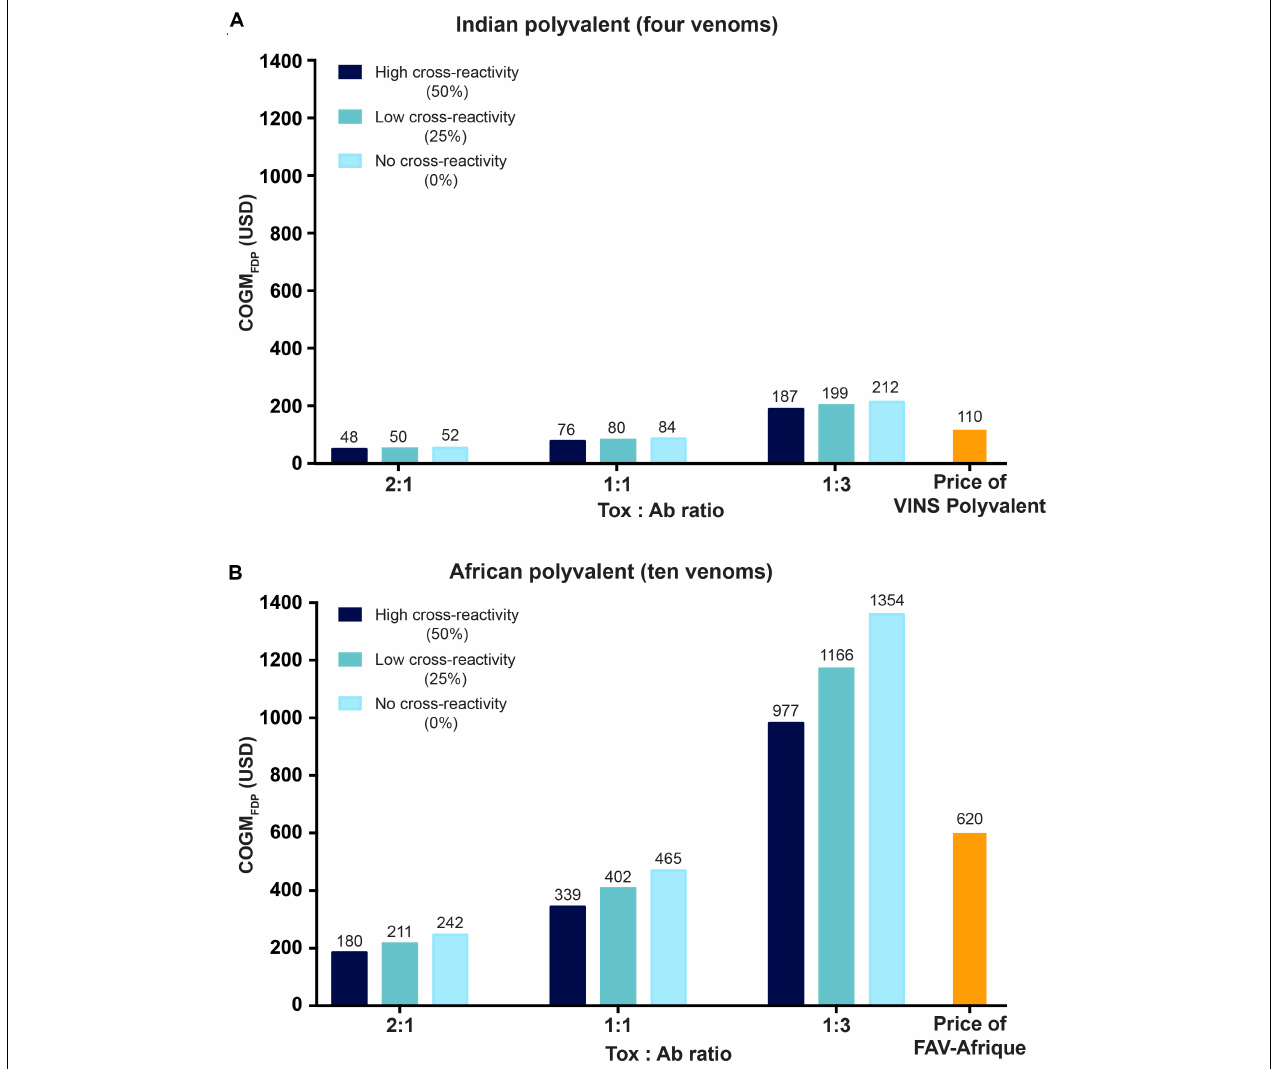
FIGURE 5 | Cost estimates for two polyvalent recombinant antivenoms. (A) Putative Cost of Goods Manufactured for the Final Drug Product (COGM FDP ) for a recombinant antivenom that can neutralize the venoms of the four most medically relevant snakes in India (i.e., Naja naja , Bungarus caeruleus , Echis carinatus , and Daboia russelii ). (B) Cost estimates for a recombinant antivenom that can neutralize 10 different species of snakes in sub-Saharan Africa (i.e., Bitis arietans, B. gabonica, E. leuconogaster, E. ocellatus, Dendroaspis polylepis, D. jamesoni, D. viridis, N. haje, N. nigricollis , and N. melanoleuca ). All of the calculations are conducted for three different toxin-to-antibody ratios (2:1, 1:1, and 1:3). Furthermore, potential cross-reactivity of the monoclonal antibodies present in the recombinant antivenoms against different venom toxins is also included, with estimates including 0% (light blue), 25% (dark turquoise), and 50% (dark blue) cross-reactivity. The costs are calculated for the final drug product, which includes formulation costs. The price per treatment for two animal plasma-derived polyvalent antivenoms for both India (VINS polyvalent) and sub-Saharan Africa (FAV-Afrique – out of production) are also provided for comparison (please note that these are sales prices, which also reflect financial parameters other than COGM alone, such as sales, distribution, indirect costs, and profit